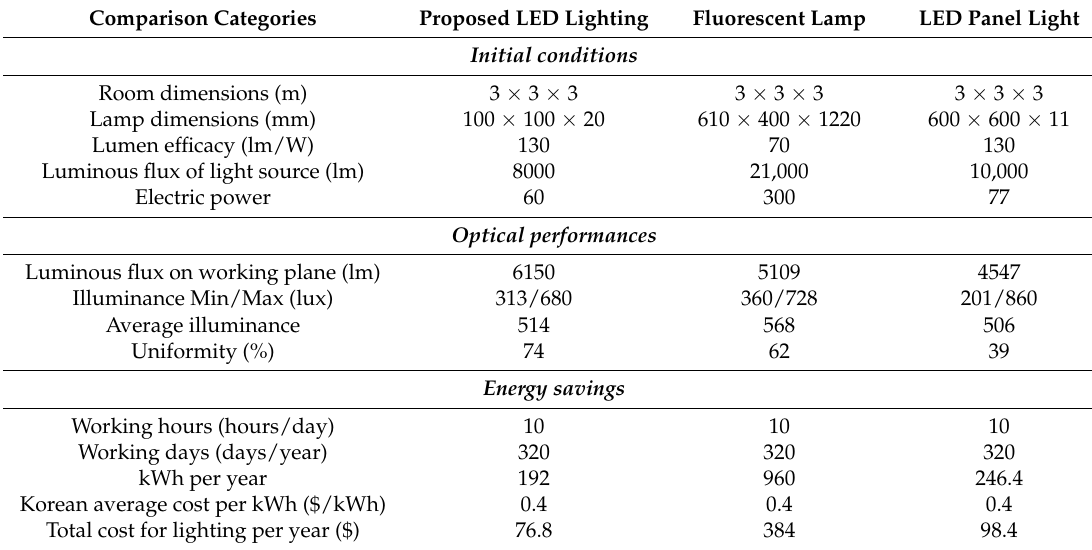
Figure 14. Light distribution on the working plane using: ( a ) our proposed lighting method; ( b ) fluorescent lamp; ( c ) commercial LED panel light. Table 2. Comparison of the performances between the three types of light source: our proposed LED source, fluorescent lamp and commercial LED panel light.